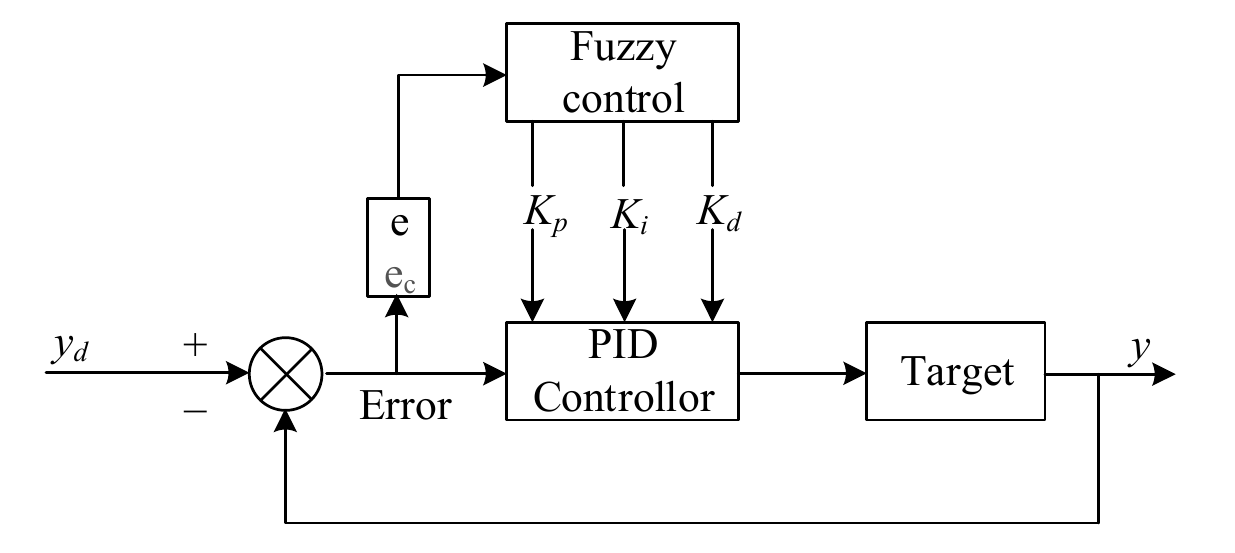
Figure 5. Principle of fuzzy adaptive PID control.